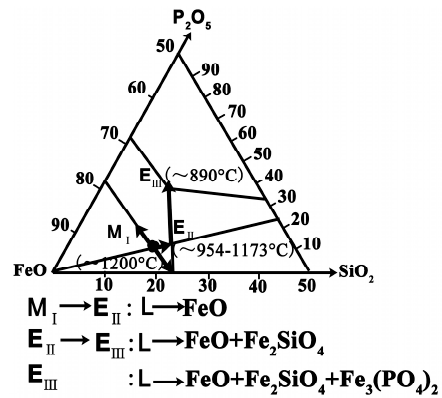
Figure 8. FeO ‐ SiO 2 ‐ P 2 O 5 ternary eutectic system. Figure 8. FeO-SiO 2 -P 2 O 5 ternary eutectic